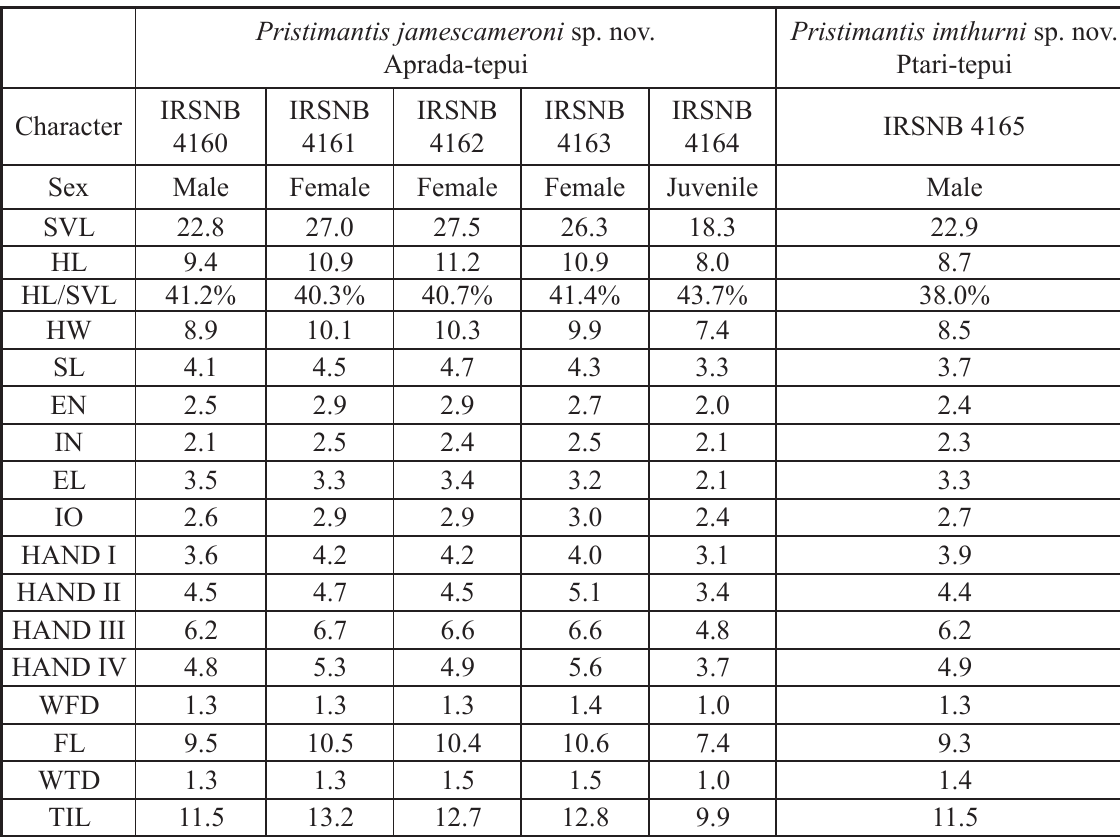
Table 1. Sex, measurements (in mm), and HL/SVL ratio of type specimens of Pristimantis